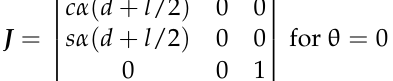
effect on changing the instrument position. The position of the manipulator can only be changed by the translation movement t z . According to the analysis of Equation (17), when θ (cid:54) = 0, the determinant of J is expressed in Equation (19). When the determinant of J is null, the other singularities of the manipulator can be obtained at θ = 107.2 ◦ as shown by the red circle in Figure 7. As shown in Figure 7, the blue part represents the workspace of the manipulator with translation DoF, and the red mark is the singularity of the manipulator. The required workspace for ESD is a spherical area with a diameter of 25 mm [20]. In Figure 7, the green spherical portion represents the required workspace, so the workspace of the manipulator could meet the needs of transluminal endoscopic